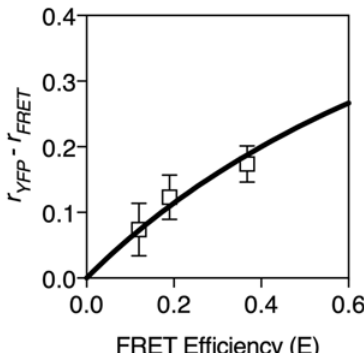
Figure 2. FRET efficiency vs. polarization. FRET efficiency increases with decreasing anisotropy. FRET efficiency for heterotransfer is plotted for various anisotropy values ( r = 0 to r = 0.3) according to Equation (8). A maximum anisotropy of 0.3 is assumed. FRET values (mean ± S.D., n = 7 cells) from previously published standards [15,39] were quantified using fluorescence polarization microscopy.